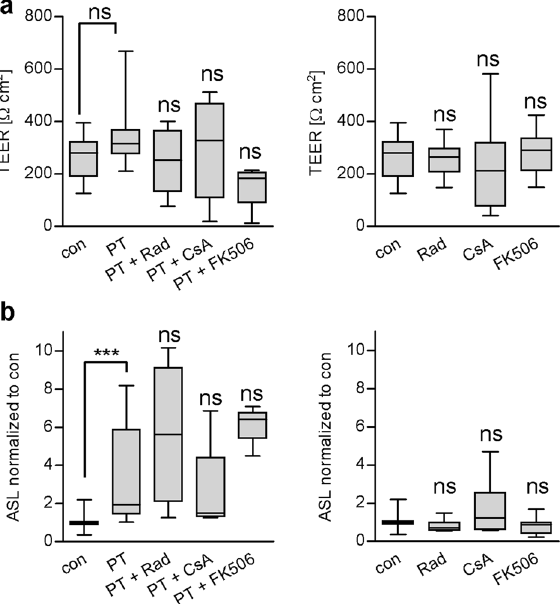
Figure 7. PT does not impair barrier function but increased apical surface liquid. ( a ) hBAECs were pre- incubated with Rad, CsA or FK506 (20 µM) for 30 min or left untreated . Then 20 µg/ml PT was added for 72 h or cells were left untreated. Transepithelial electrical resistance (TEER) was measured using CellZScope from NanoAnalytics. ( b ) hBAECs were treated as described in A. After 72 h the apical surface liquid was determined. Values were obtained from at least two independent experiments (n ≥ 4). Significance was tested by Kruskal– Wallis test and refers to samples treated with only PT or as indicated (***p < 0.001, ns not significant).